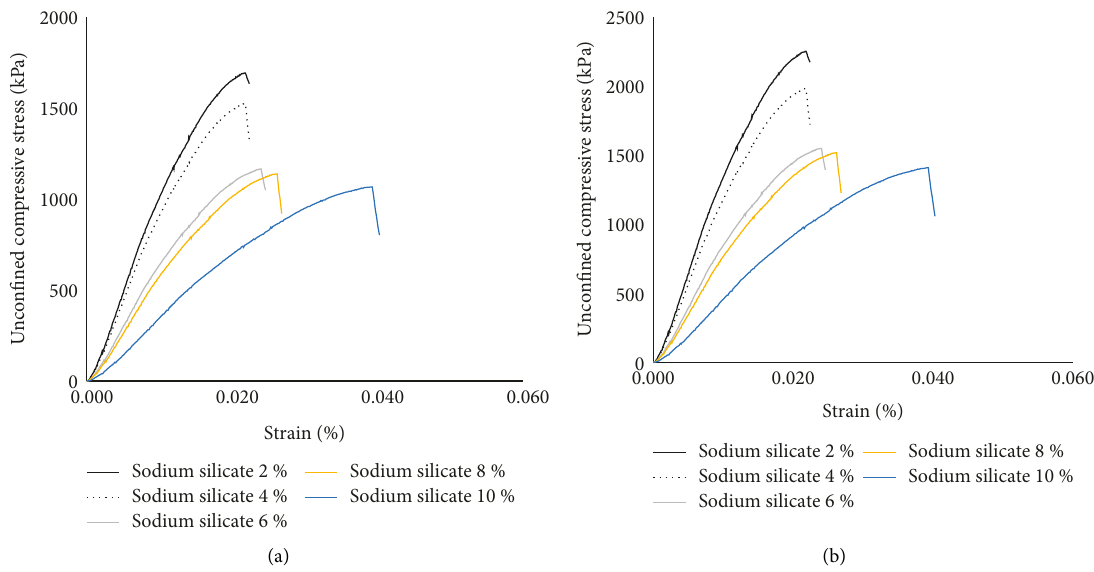
Figure 10: Results of the uniaxial soil compaction test, 25% cement and different percentages of sodium silicate. (a) 7-day curing and (b) 28- day curing.